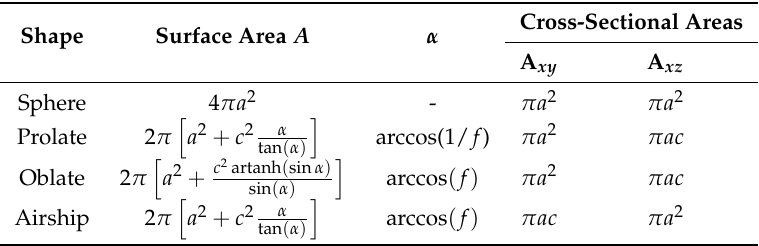
Table 2. The area parameters of different shapes. The surface area A is a function of a , c , and α , where α is a function of f that depends on the shape.